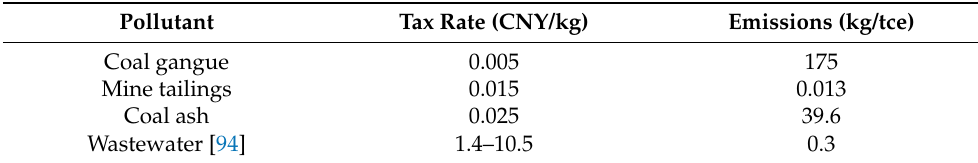
Table A15. Coal mining pollutant tax and emissions rates